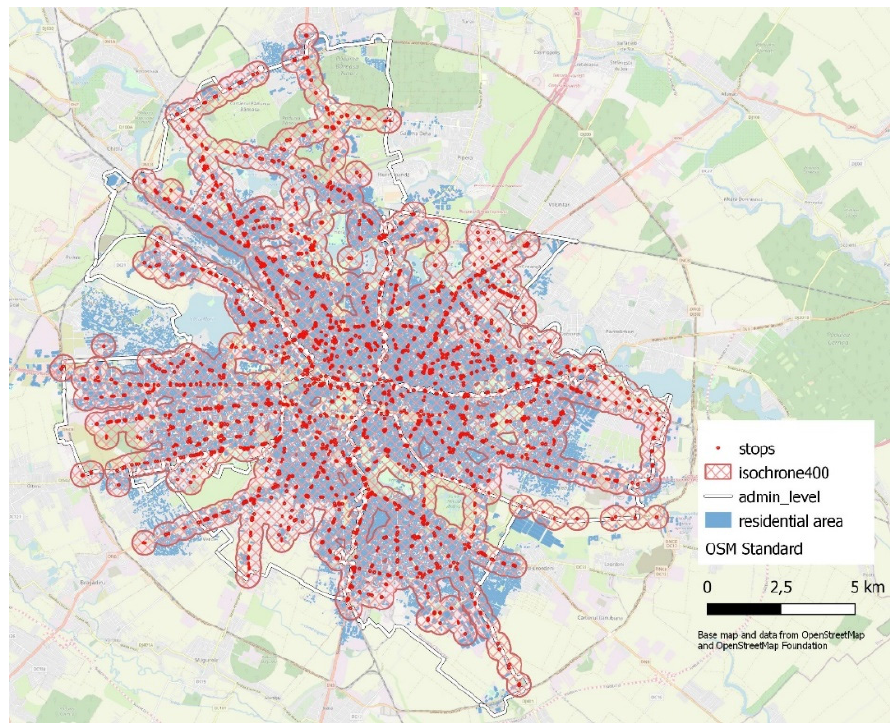
Figure 8. Accessibility of public transport stations (isochrone 400 m) (© OpenStreetMap contribu- tors).